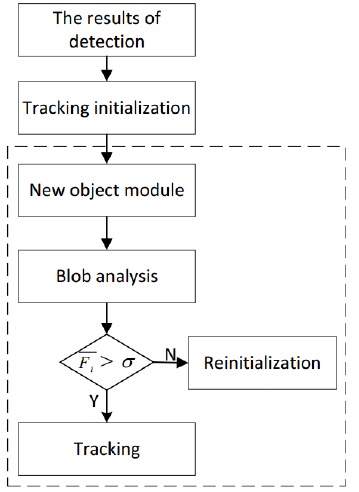
Figure 5. Multi-vehicle management module. Inside the dashed box is tracking module which connects detector and tracker. It consists of new object module, blob analysis and multi-object